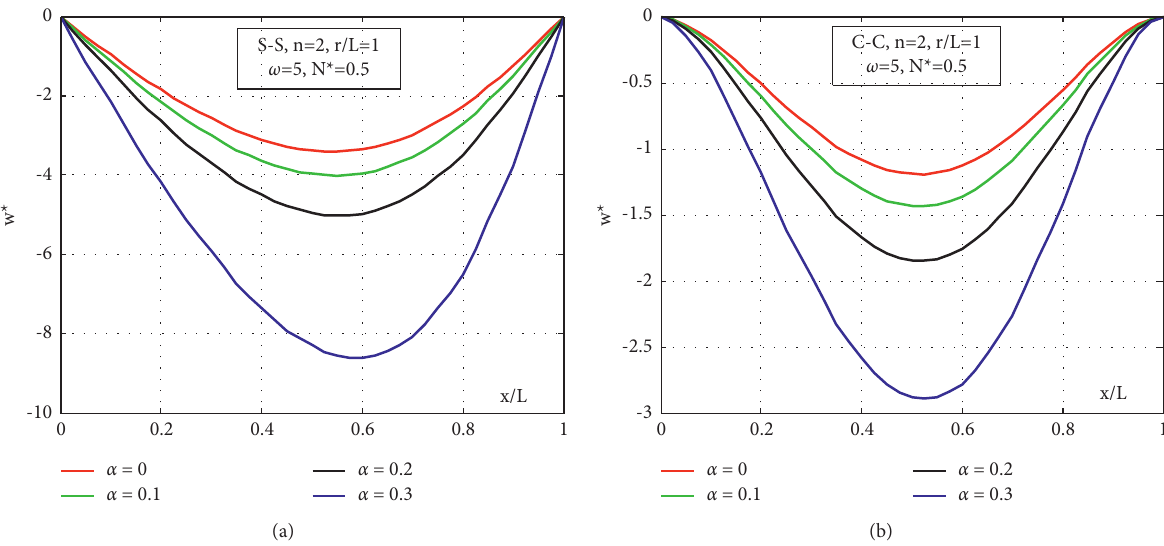
Figure 9: The relationship between the porosity volume fraction α and the FG beam’s deflection curve, K ∗